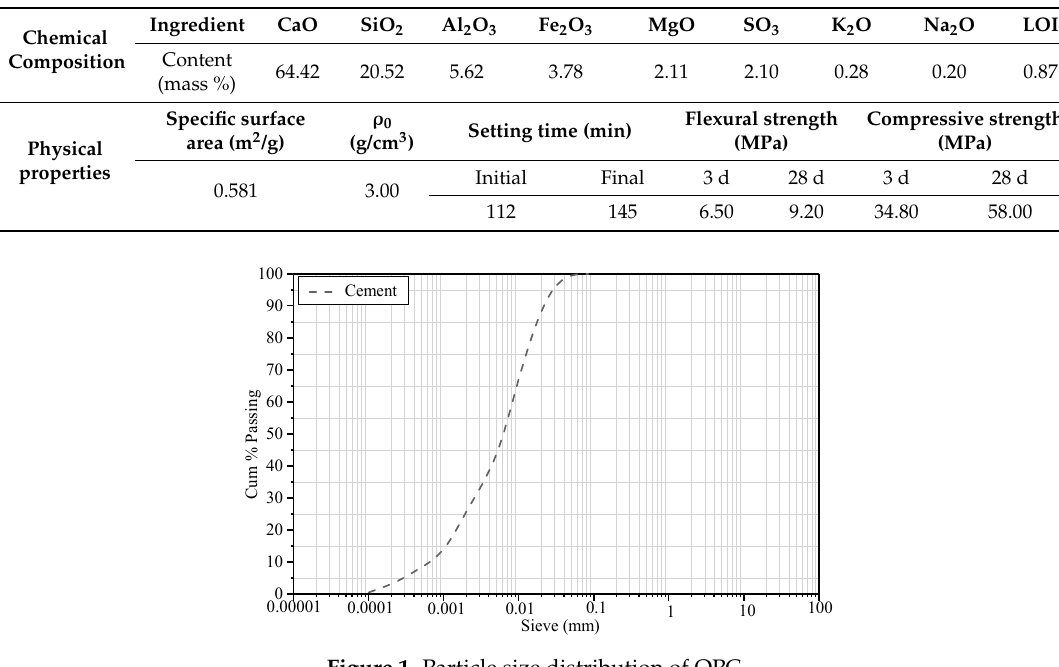
Table 3. Characteristics of chemical